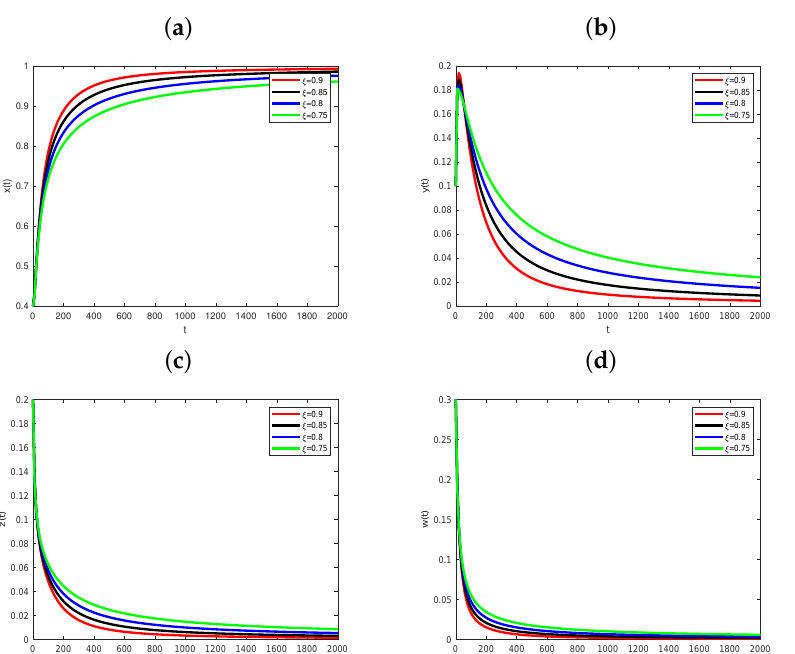
Figure 1. Graphs for the numerical solution of the fractional-order model investigated in this work. The graphs were obtained using the numerical method introduced in the previous section, and they provide the dynamics of ( a ) x vs. t , ( b ) y vs. t , ( c ) z vs. t , and ( d ) w vs. t . The parameters employed to produce these simulations were those provided in Table 1 for the disease-free case. As indicated by the legends, various differentiation orders ξ were employed.